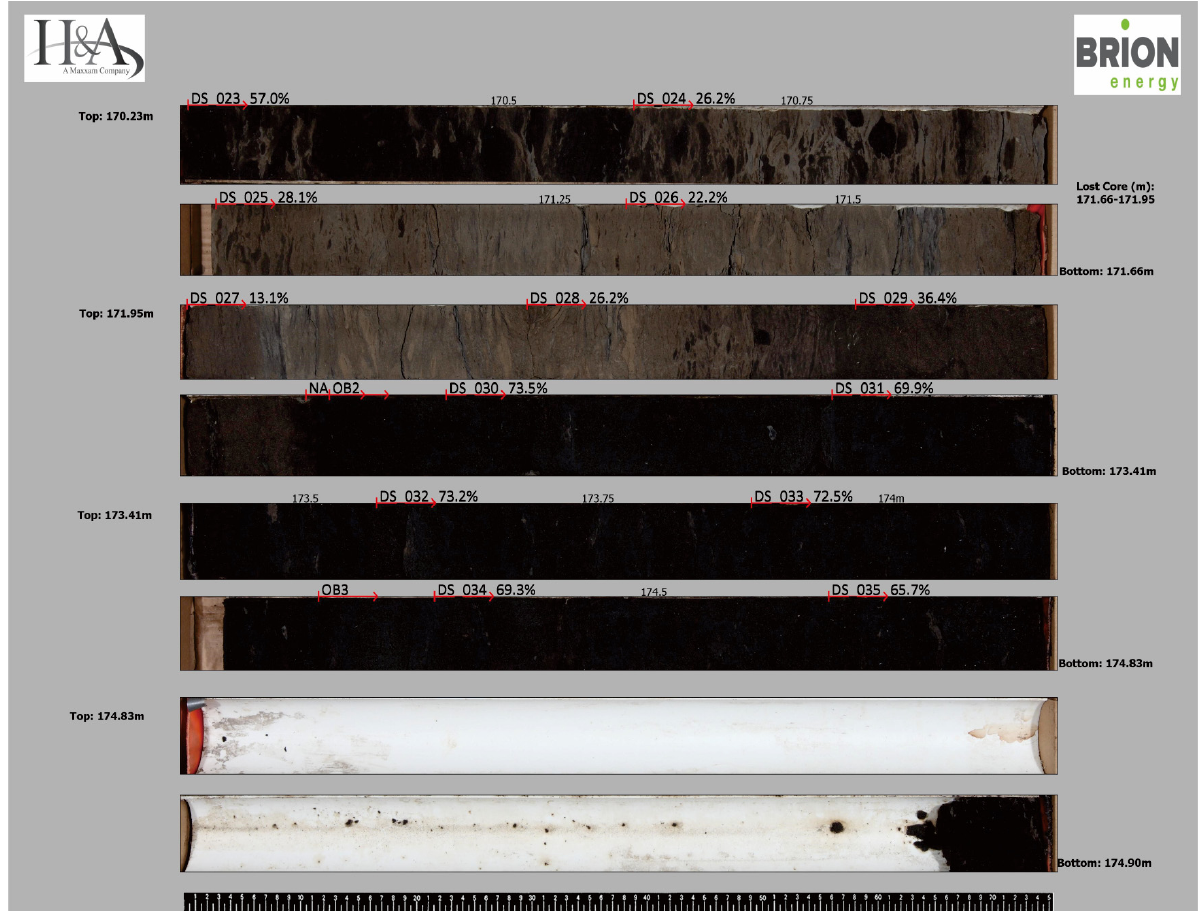
Figure 1. Typical core photograph of the study area.